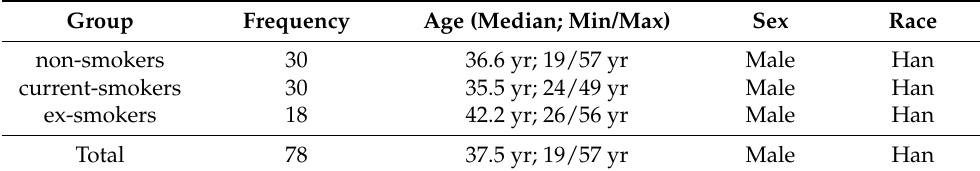
Table 1. Characteristics of the subject sample ( n = 78).